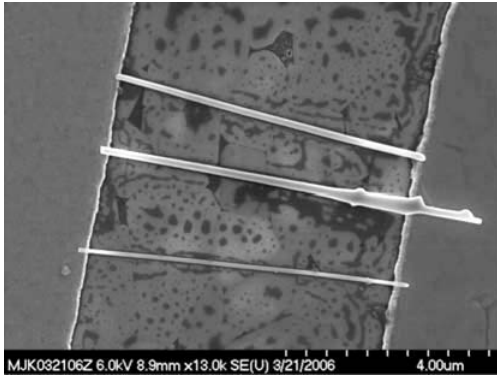
Figure 15. Ideal characteristics are illustrated by the bridging of single nanowires and parallel alignment with each nanowire forming individual contacts across